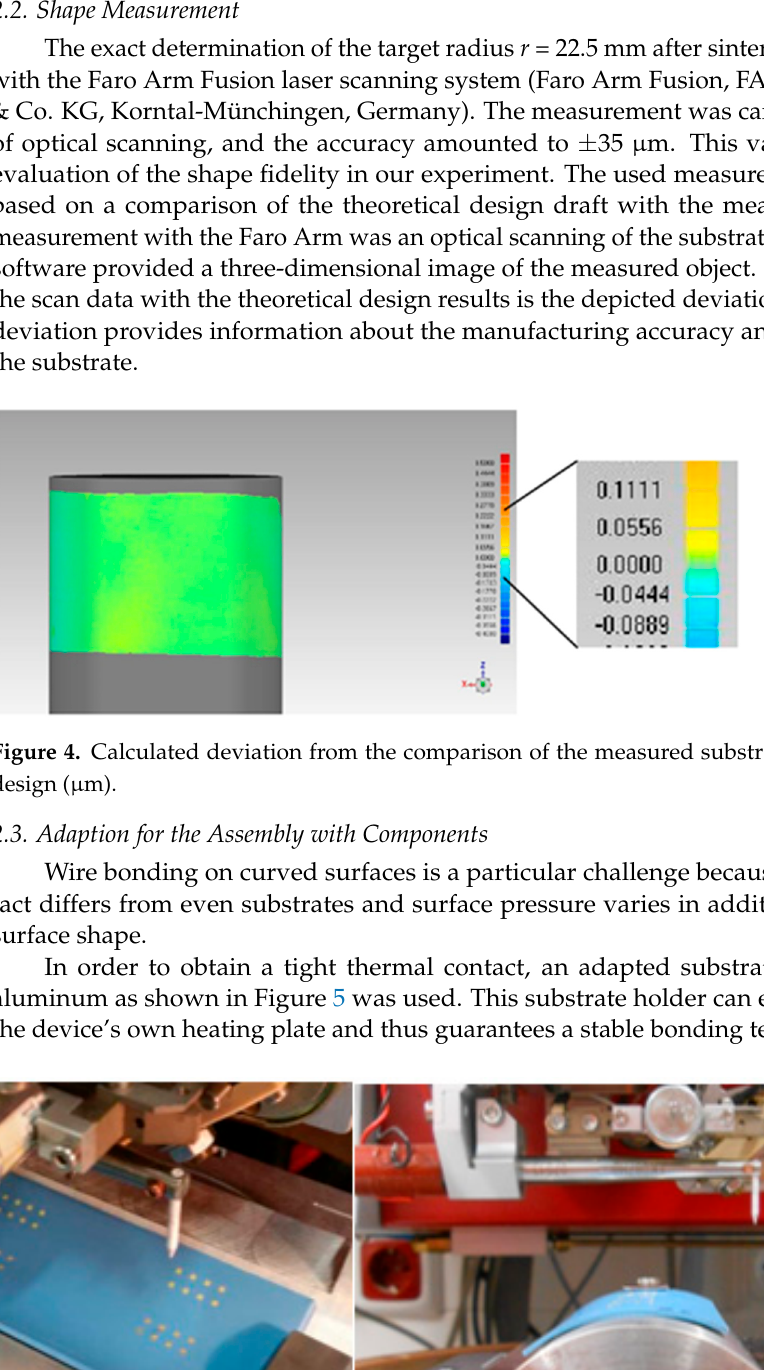
Figure 3. X-ray images of the two different daisy chains; ( a ) daisy chain sized 60 mm × 60 mm; ( b ) daisy chain sized 30 mm × 4 mm.